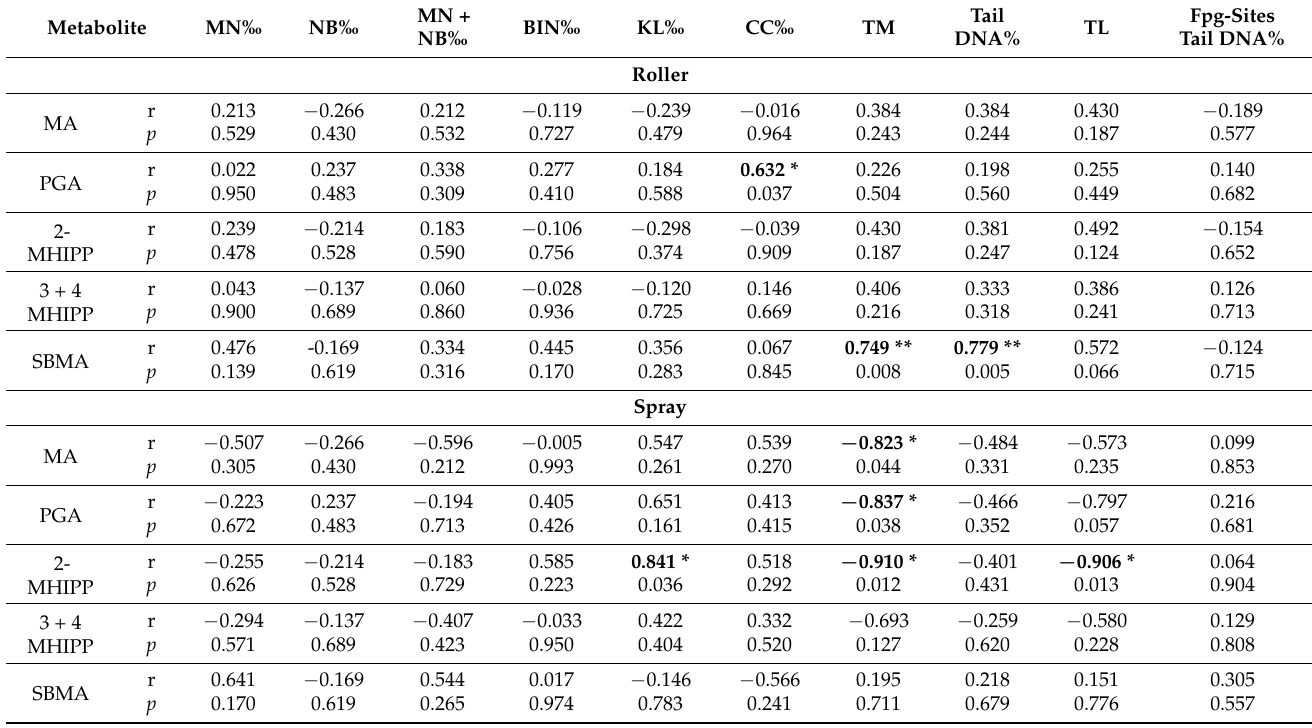
Table 5. Pearson’s correlation analysis between urinary biomarkers of exposure and biomarkers of effect in the two groups of